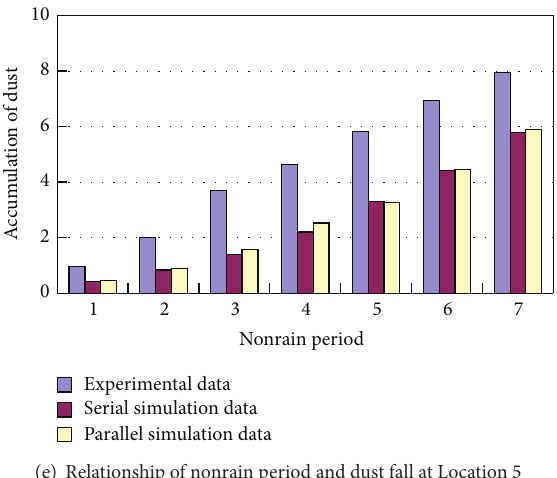
Figure 8: Comparison of experimental and simulation results of dust fall